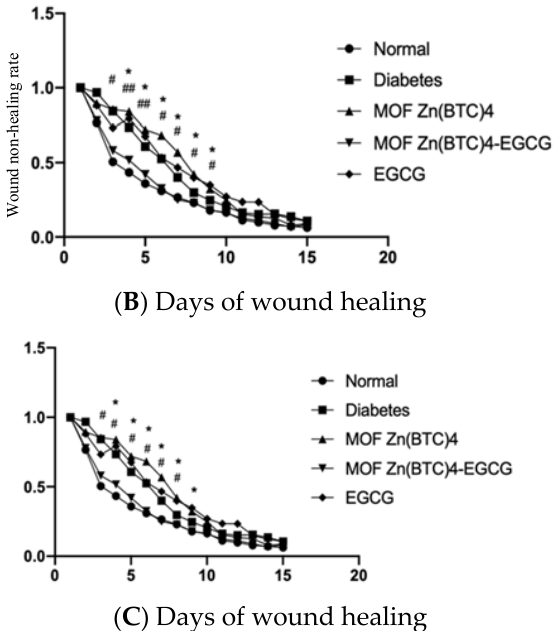
Figure 8. Wound healing and the broken line chart of the wound non-healing rate. ( A ) Wound conditions at different time points with treatment every 4 days; ( B ) Wound non-healing rate in the normal and model groups; ( C ) Wound non-healing rate, normal group vs. MOF Zn(BTC) 4 , p < 0.05; MOF Zn(BTC) 4 vs. EGCG @ MOF Zn(BTC) 4 , p < 0.05,B and C respectively indicate the arrogance between different groups.